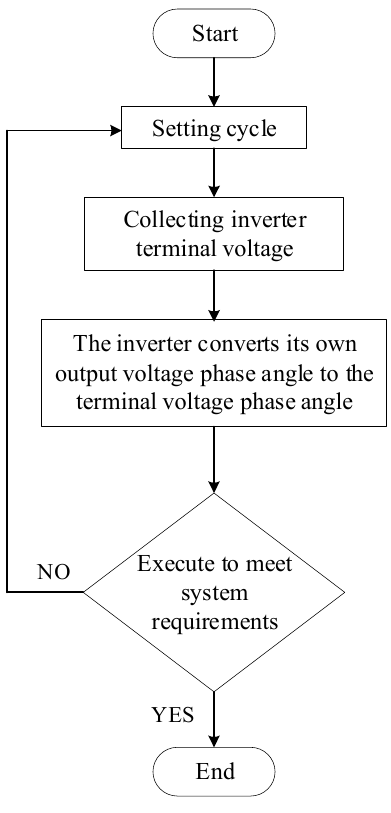
Figure 13. Phase angle self-synchronization strategy flow chart.